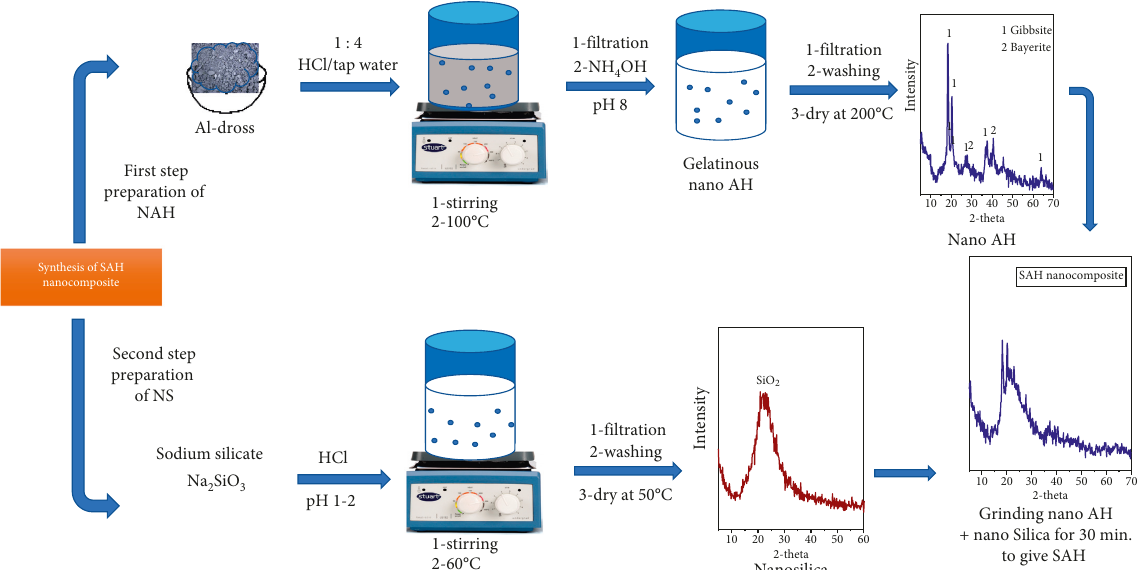
Figure 1: A flow chart of the synthesis process of the silica-gibbsite (NSG)